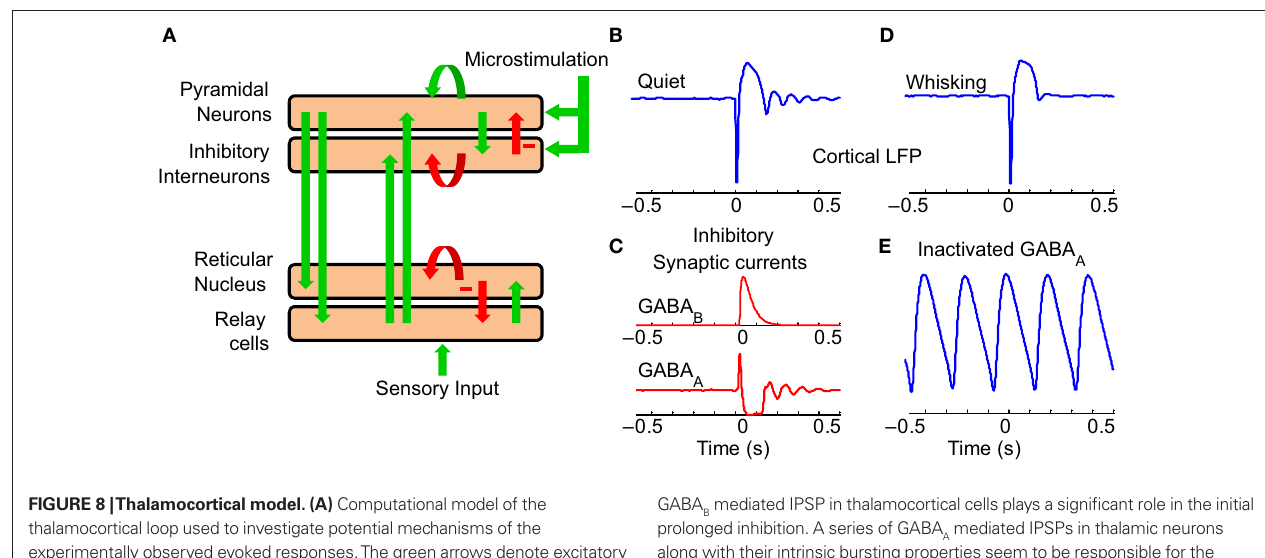
FIGURE 8 | Thalamocortical model. (A) Computational model of the thalamocortical loop used to investigate potential mechanisms of the experimentally observed evoked responses. The green arrows denote excitatory connections and the red arrows inhibitory. (B) Evoked LFP response of the thalamocortical model to a burst of spikes in the cortex (at 0 s) shows a similar response to experimentally observed data. (C) The model suggests that a